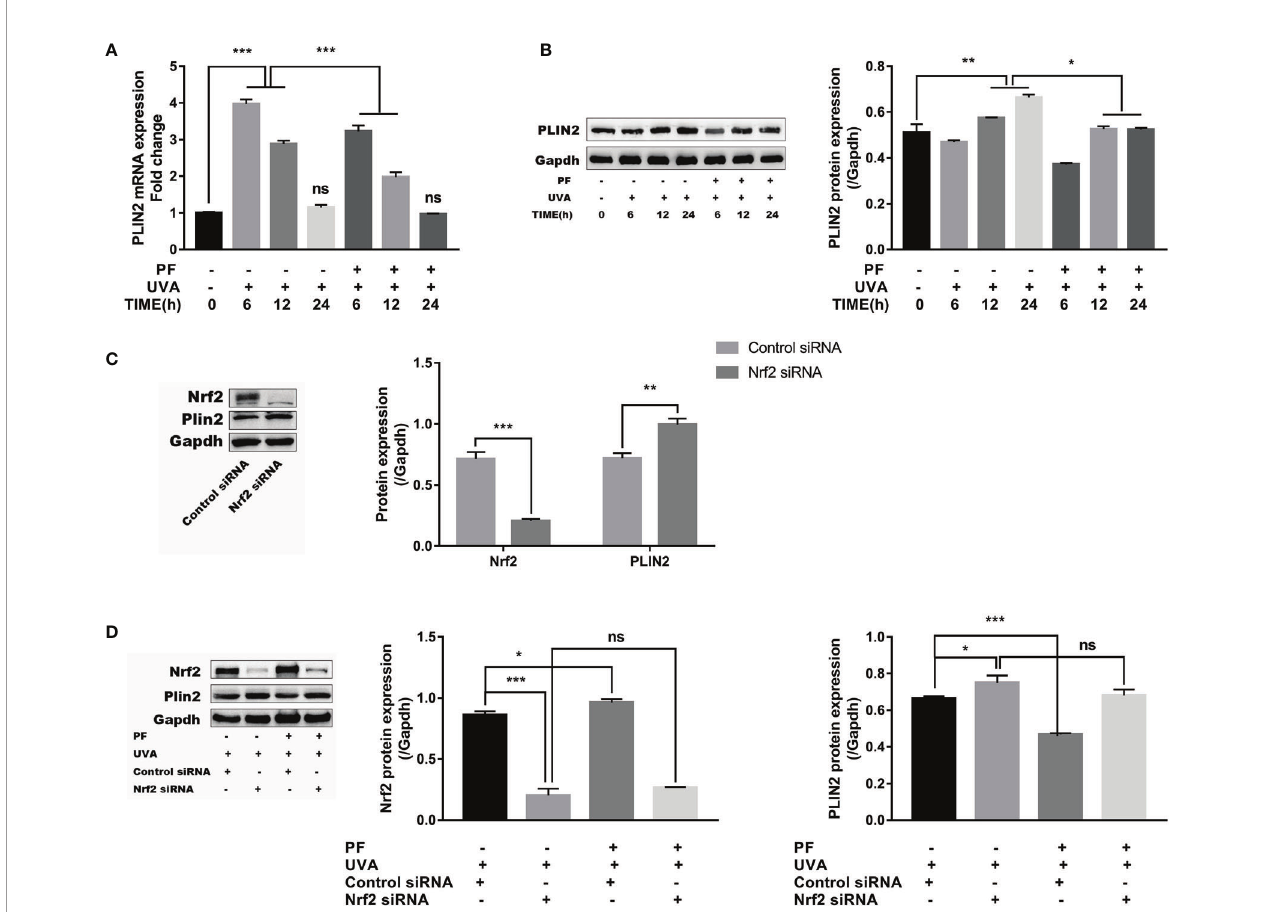
FIGURE 4 | Regulation of PLIN2 by UVA and PF. (A) The effects of UVA and PF pre-treatment +UVA on the mRNA expression of PLIN2 tested by RT-qPCR at time points of 6, 12, and 24 h. (B) The effects of UVA and PF pre-treatment +UVA on the protein expressions of PLIN2 tested by Western blot at time points of 6, 12, and 24 h. (C) The protein expression of PLIN2 after Nrf2 was knocked down in fi broblasts. (D) The protein expression of PLIN2 in fi broblasts with UVA radiation and PF-pretreatment in absence of Nrf2. The representative result of western blot and the quantitative analyses of three independent experiments were shown (B, D) . All data were expressed as the mean ± SD according to at least three independent experiments. * p < 0.05, ** p < 0.01, *** p < 0.001, ns p >